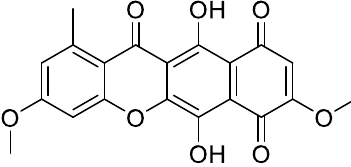
Figure 1. Bikaverin (6,11-dihydroxy-3,8-dimethoxy1-methylbenzo[b]xanthene-7,10,12-trione), a natural compound isolated from Fusarium vasinfectum that shows inhibitory activity toward CK2